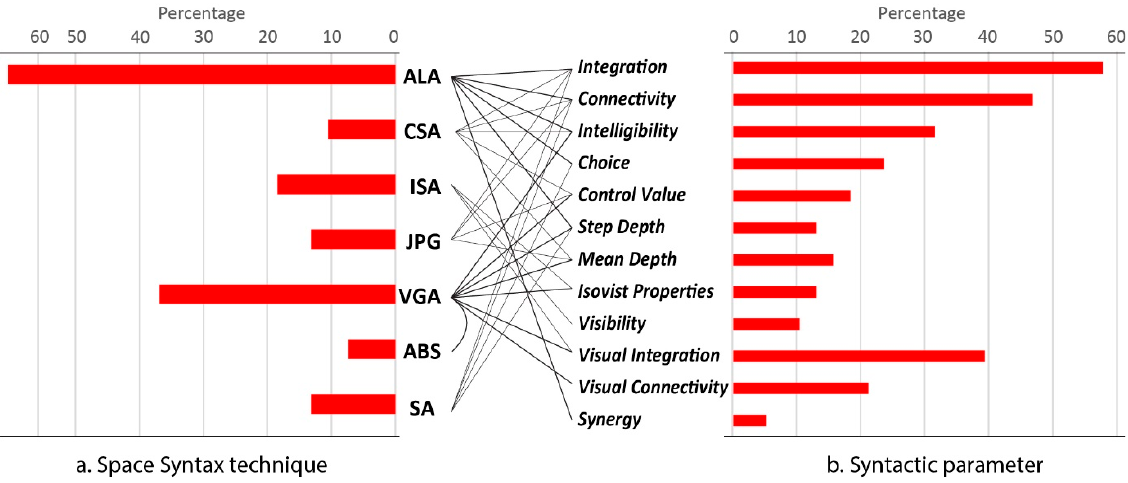
Figure 3. The percentage of articles using specific space syntax techniques and syntactic